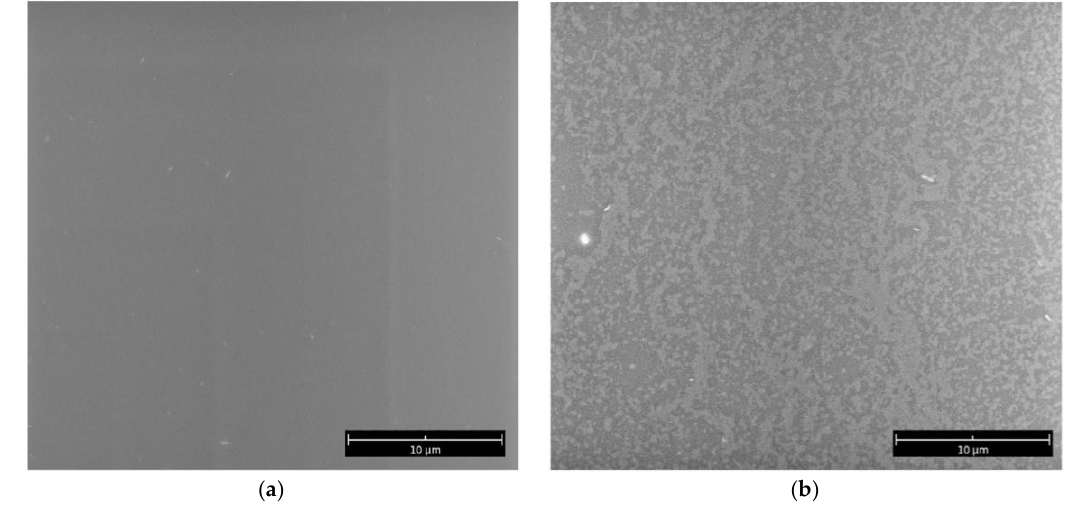
Figure 11. SEM images of the virgin ( a ) and laboratory ACR coated ( b ) substrates.